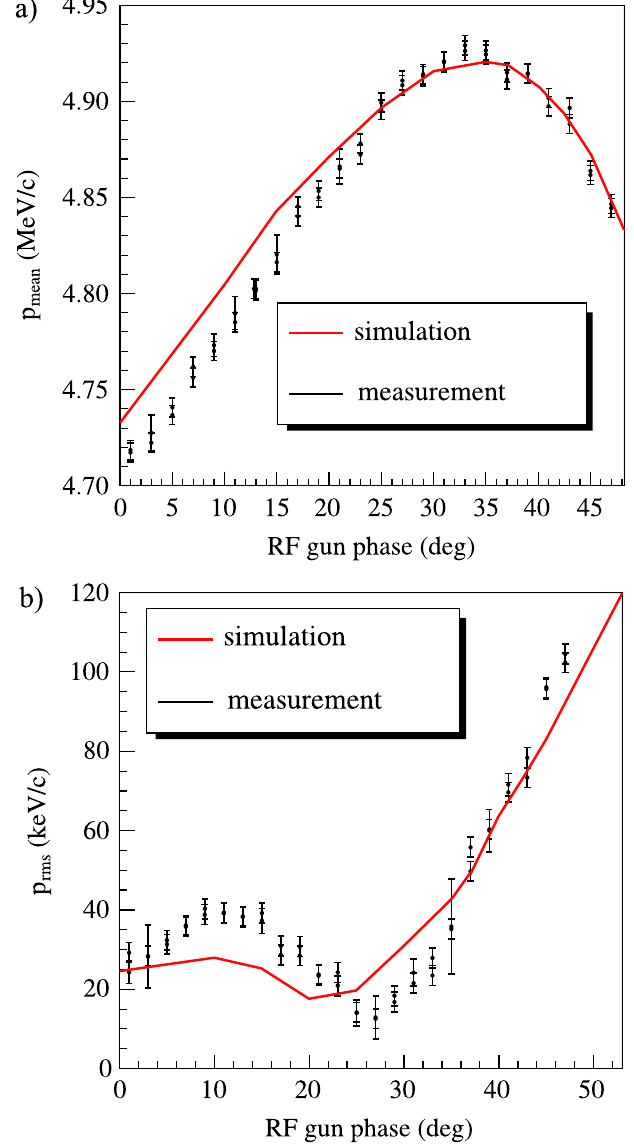
FIG. 23. (Color) Measured and simulated (a) mean momentum and (b) momentum spread of the electron beam from gun prototype 3.1 with a peak field at the cathode of about 40 MV = m .